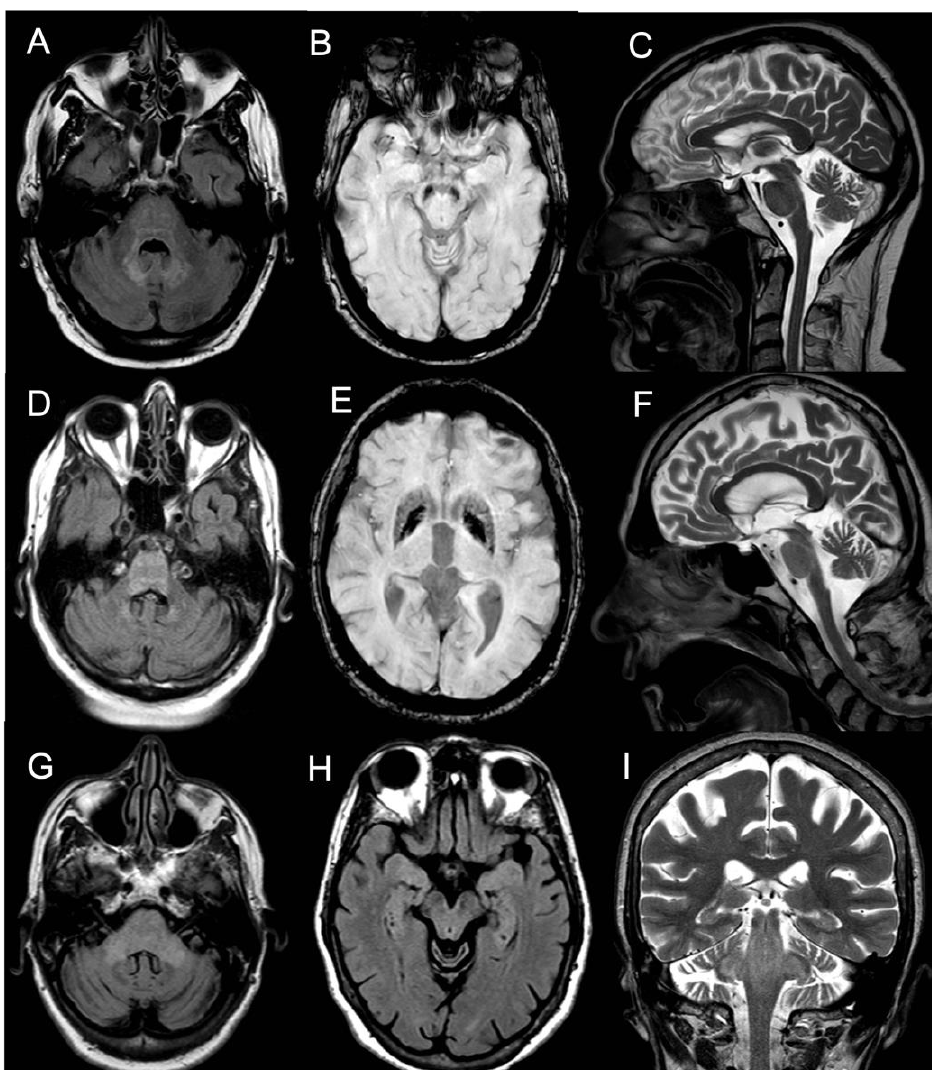
Figure 1. Panel showing brain MRI of Pt #1 ( A – C ), Pt #3 ( D – F ), and Pt #4 ( G – I ). ( A ) Transverse FLAIR scan (pons level) of Pt #1 showing mild hyperintensity of the pons, both MCPs, dentate nuclei. ( B ) Transverse SWAN scan (mesencephalon level) of Pt #1 showing marked hypointense signal (metal deposits) of bilateral substantia nigra. ( C ) Sagittal T2-weighted scan of Pt #1 showing slight vermian cerebellar atrophy. ( D ) Transverse FLAIR scan (pons level) of Pt #3 showing hyperintensity of the pons and dentate nuclei. ( E ) Transverse SWAN scan (thalami level) of Pt #3 showing marked hypointense signal (metal deposits) of putamina and globi pallidi. ( F ) Sagittal T2-weighted scan of Pt #3 showing vermian cerebellar atrophy. ( G ) Transverse FLAIR scan (pons level) of Pt #4 showing hyperintensity of the pons and both MCPs. ( H ) Transverse FLAIR scan (mesencephalon level) of Pt #4 showing hyperintensity of the mesencephalon and parahippocampal cortices. ( I ) Coronal T2-weighted scan of Pt #4 showing hyperintensity of the pons, both SCPs and MCPs. Abbreviations: Flair: fluid-attenuated inversion recovery; MCP: middle cerebellar peduncle; SWAN: susceptibility-weighted angiography; SCP: superior cerebellar peduncle.